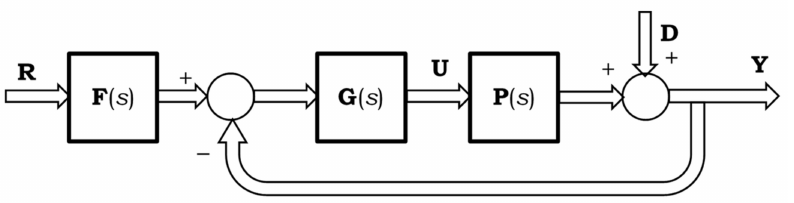
Figure 1. A two-degree-of-freedom MIMO feedback control system block diagram. R , U , D , and Y are the system reference, plant input, plant disturbance, and system output vectors respectively. Signal flow direction is shown with the arrows on double lines and the circles indicate summation of entering signals. P is the given system transfer matrix. G is the to be designed feedback controller matrix. F is the feed forward reference filter matrix – it may be used for some engineering purposes, but is assumed to be a unit matrix in the following